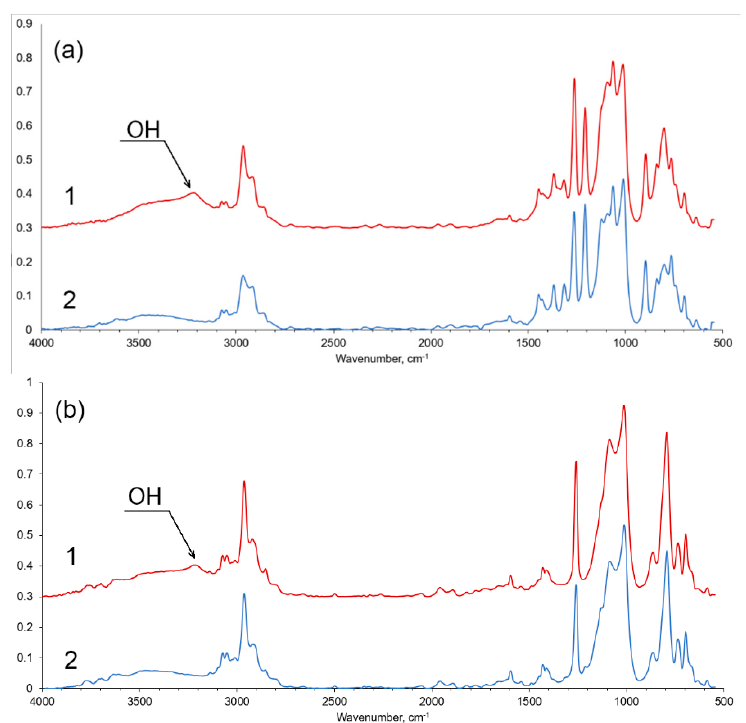
Figure 3. FTIR spectra of neat copolymer IV (1) and after modi fi cation (2) ( a ); of neat copolymer III (1) and after modi fi cation (2) ( b ).